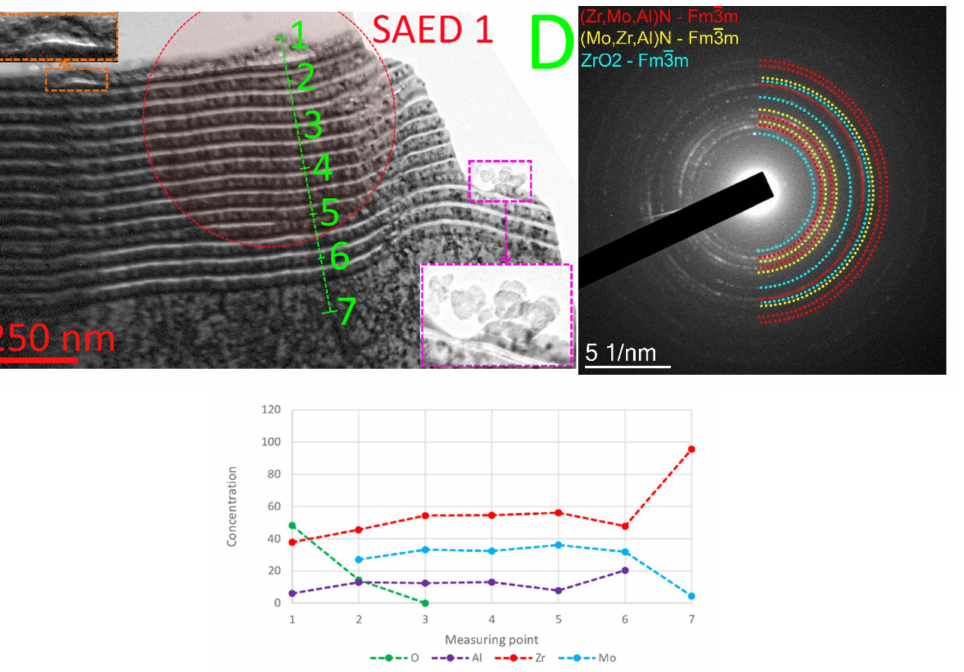
Figure 7. Oxidation processes in the worn area of the (Zr,Mo,Al)N coating. Localization of the study area D is exhibited in Figure